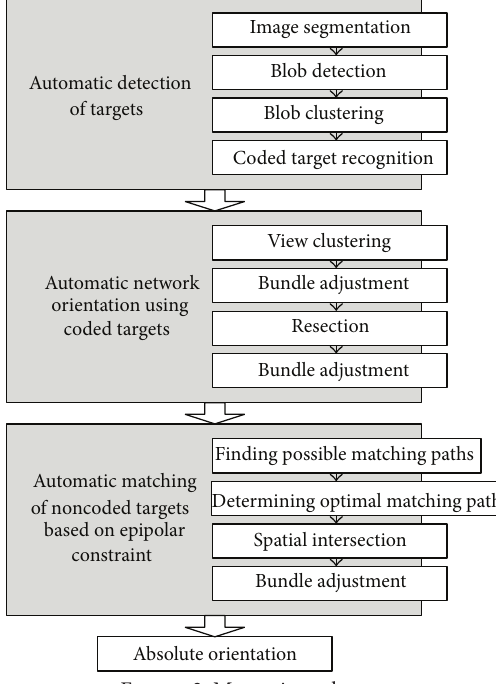
Figure 2: Measuring scheme.